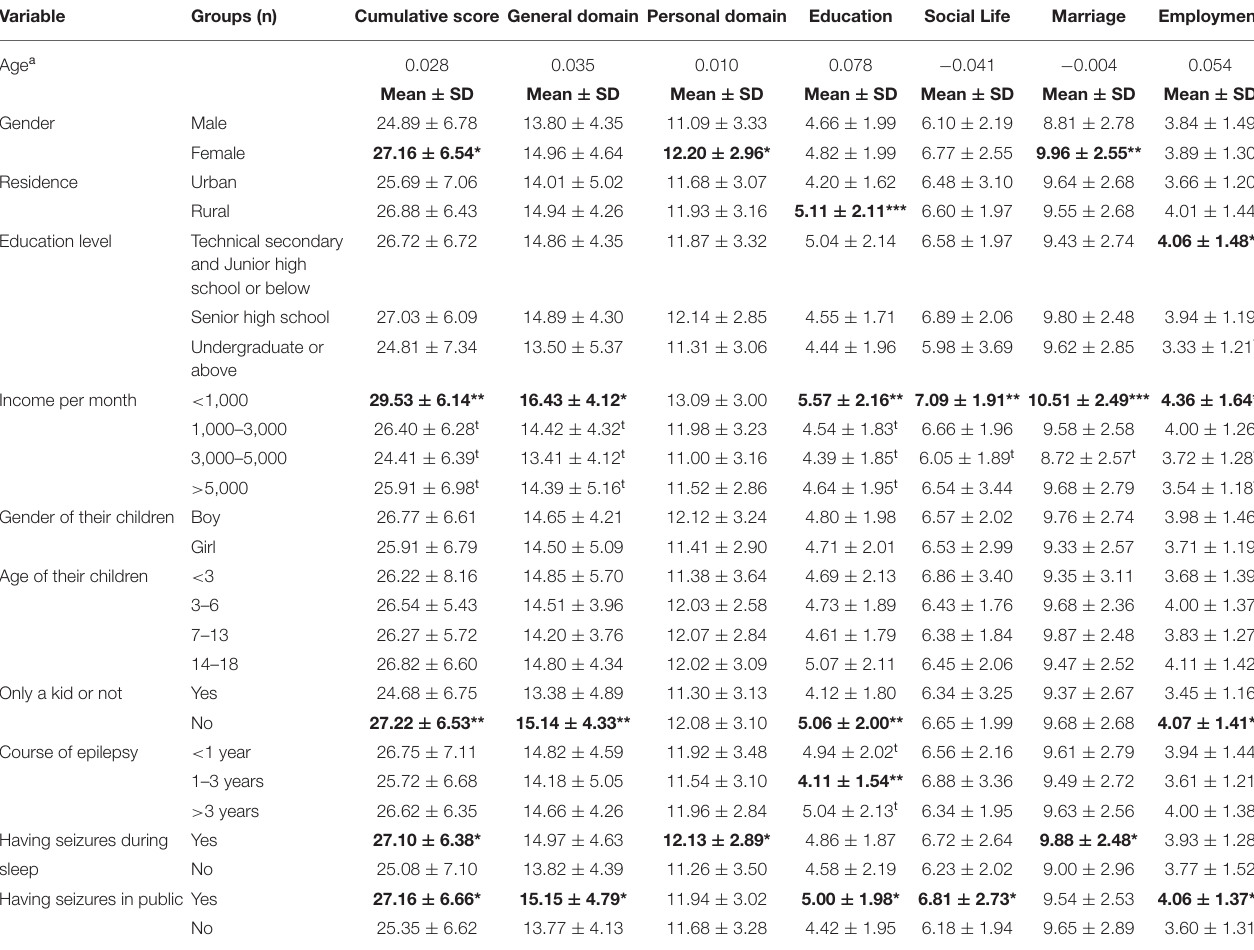
TABLE 3 | Mean scores by domains, social aspects of life, and demographic characteristics among parents of children with epilepsy.